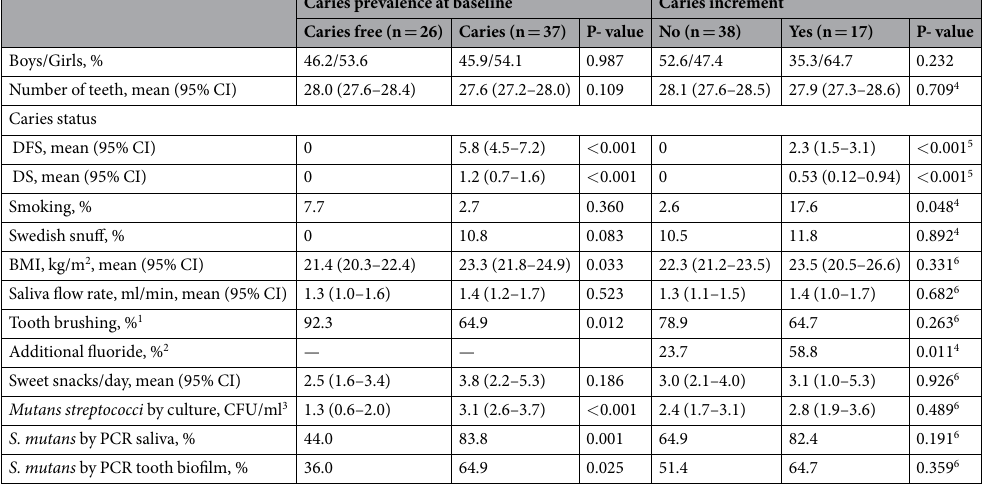
Table 2. Participant characteristics. Participants were 17 years old at recruitment with follow-up 2 years later. Caries was defined as DFS > 0 and caries-free as DFS = 0. Caries increment was defined as DFS at follow-up - DFS at baseline. Differences in subject distributions were tested with Chi 2 test among groups, and differences between group means were tested with Student’s t-test. Adjustment for sex or number of teeth did not alter the relation between groups for any variable. 1 Proportion brushing twice a day or not are compared. All brushed at least 3–4 times a week. 2 Additional fluoride refers to rinsing, varnish, tablets, gel treatments. Information only available in 19-year olds. All used fluoridated tooth paste. 3 Mean (95% CI) for log 10 of colony forming units (CFU) per ml chewing stimulated saliva. 4 Information at 19-years of age. 5 2-year caries increment. In adolescent with no 2-year increment, 52.2% were caries-free and 47.4 had caries at baseline, whereas those 94.1% with 2-year increment had caries at baseline. 6 Data are based on information at 17-years of age.